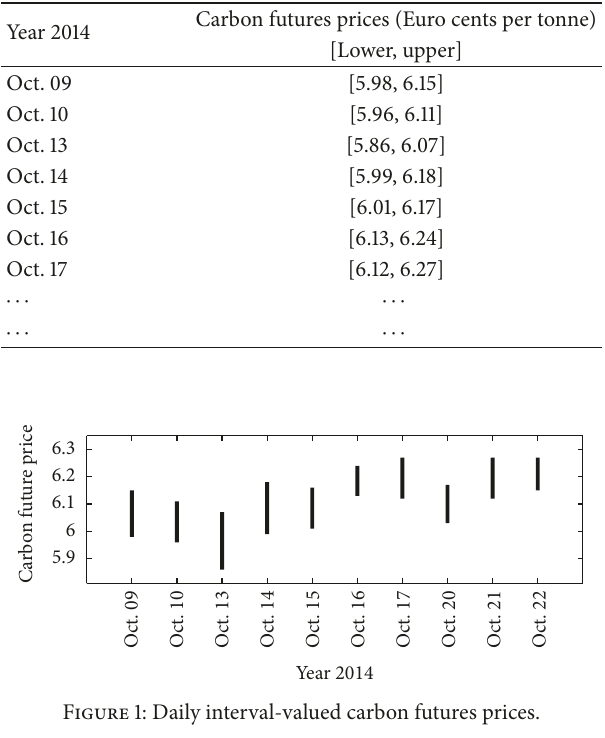
Table 1: Interval-valued variable.